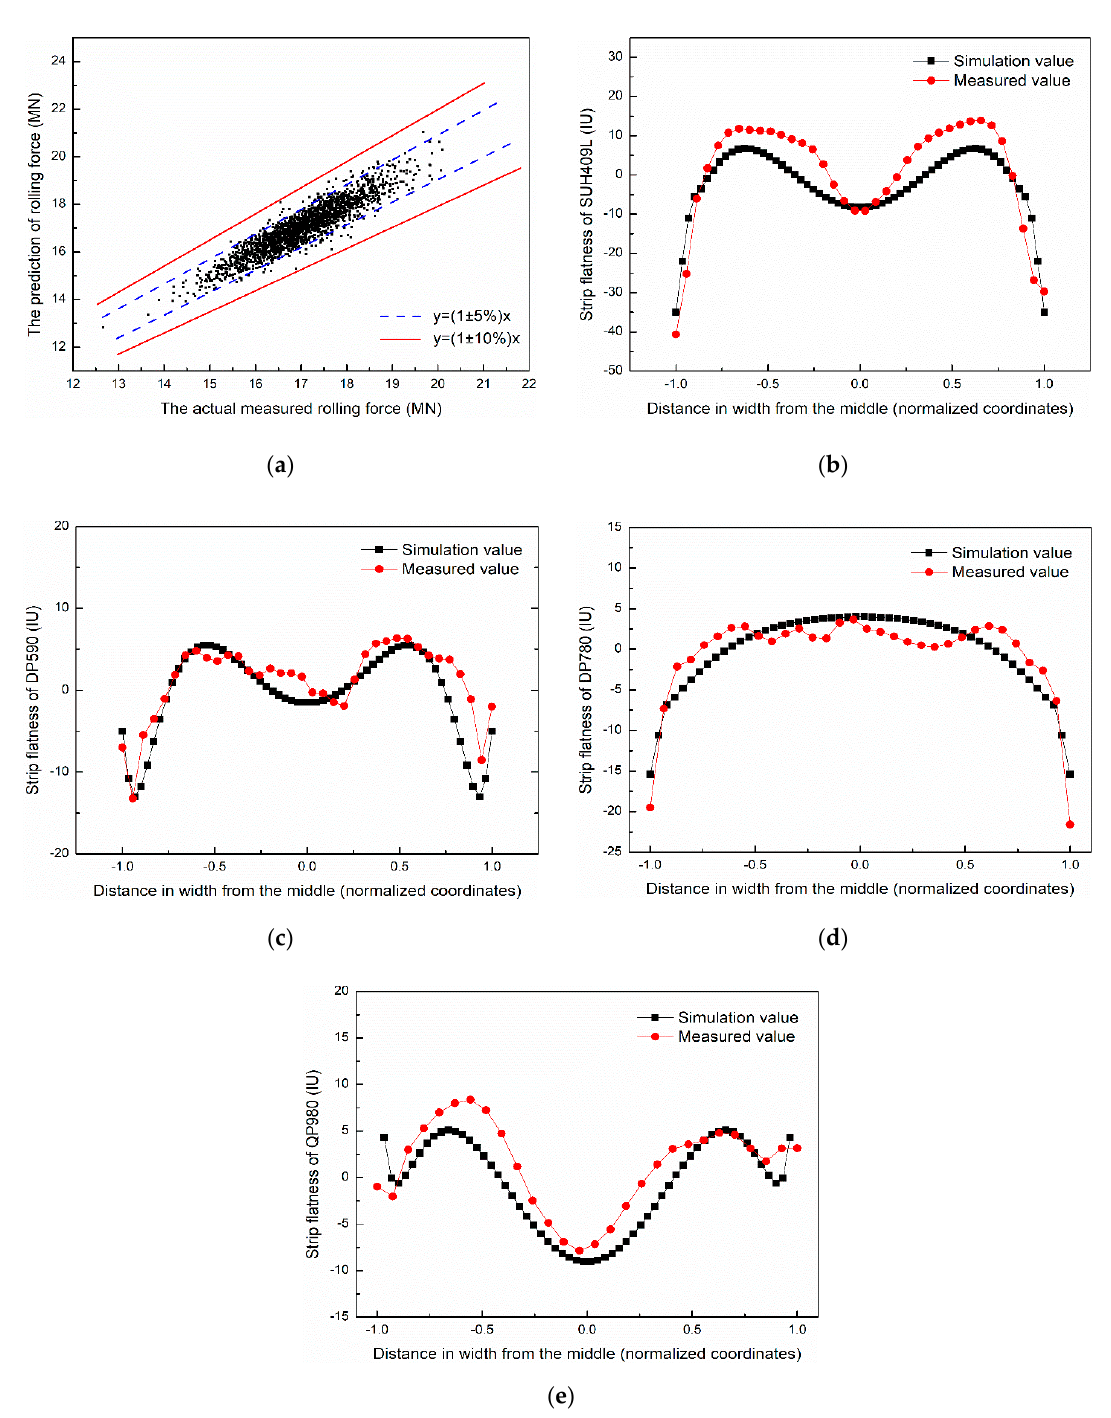
Figure 7. The verification result of ( a ) rolling force and ( b ), ( c ), ( d ), ( e ) strip flatness. Table 1. The error indexes of rolling force and strip The error distribution histogram of rolling force and strip flatness are shown in Figure 8. As indicated in Figure 8, the overall error is approximately symmetrical normal distribution, and the error distribution histogram is stable. To evaluate the flatness prediction model more quantitatively,